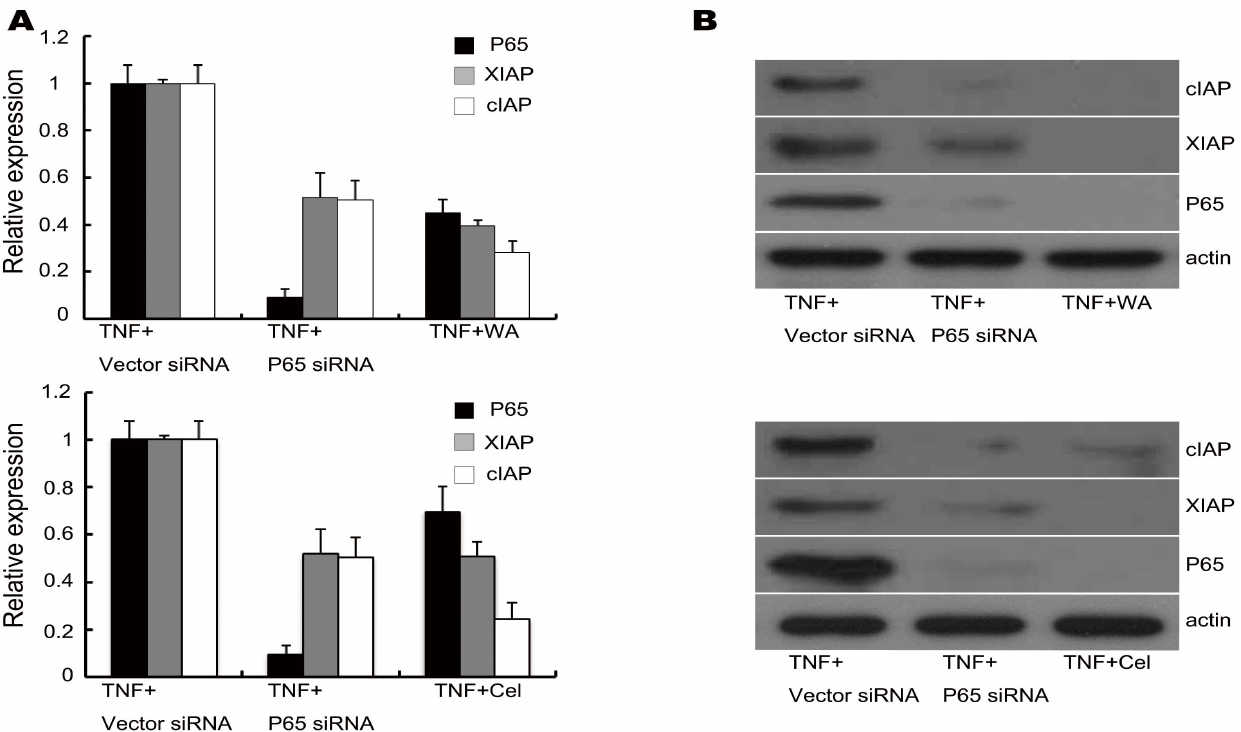
Figure 7. Inhibition of NF- k B target gene expression by WA/Cel and small interfering RNA. (A) MDA-MB-231 cells were transfected with si RNA against NF- k Bp65 for 6 hours. As a negative control, cells were transfected with the same amount of non targeting control - si RNA. Following transfection, cells were treated with TNF- a (10 ng/ml) for 24 hours. Cells that were not transfected were treated with TNF- a (10 ng/ml) plus WA (5 m M) or Cel (2.5 m M) for 24 hours. The mRNA levels of NF- k B-p65, XIAP and cIAP1/2 were detected by RT-qPCR. (B) MDA-MB-231 cells were transfected with si RNA against NF- k Bp65 for 6 hours. The negative control was treated with the same amount of vector- si RNA. Following transfection, cells were treated by TNF- a (10 ng/ml) for 48 hours. Cells that were not transfected were treated with TNF- a (10 ng/ml) plus WA (5 m M) or Cel (2.5 m M) for 48 hours. The levels of NF- k Bp65, XIAP and cIAP1/2 proteins were detected by Western blotting. Data are shown as mean ¡ SD of three